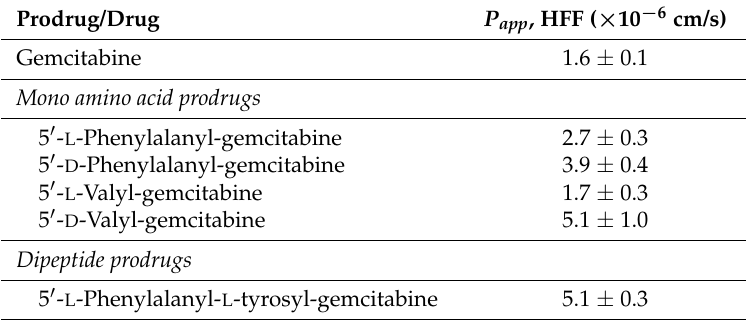
Table 6. Apparent permeability coefficients ( P app ) of gemcitabine and monoester prodrugs of